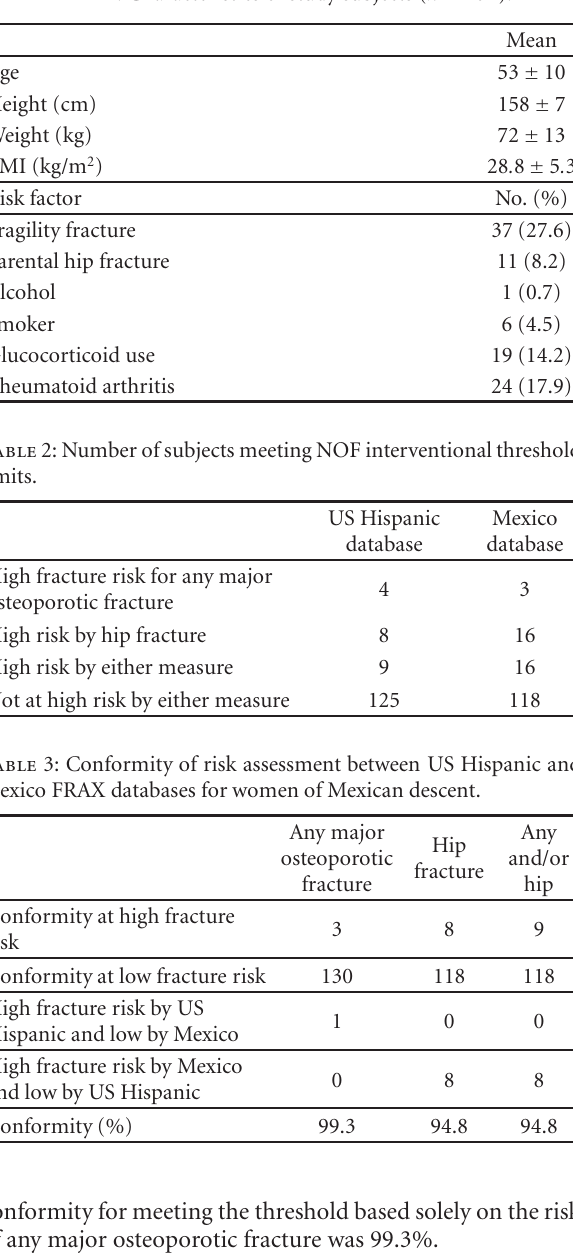
Table 1: Characteristics of study subjects ( n = 134).